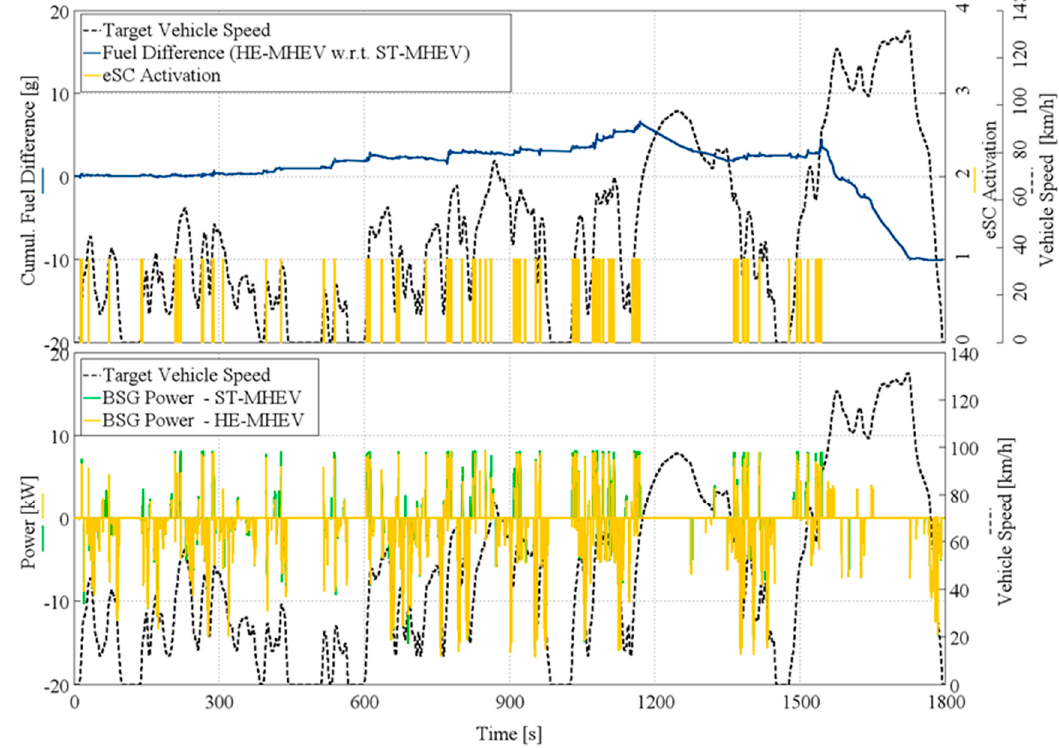
Figure 13. Focus on electric power management in the WLTC. Top chart: eSC activation and cumulated fuel difference (HE-MHEV w.r.t. ST-MHEV). Bottom chart: BSG mechanical power for ST-MHEV and for HE-MHEV.